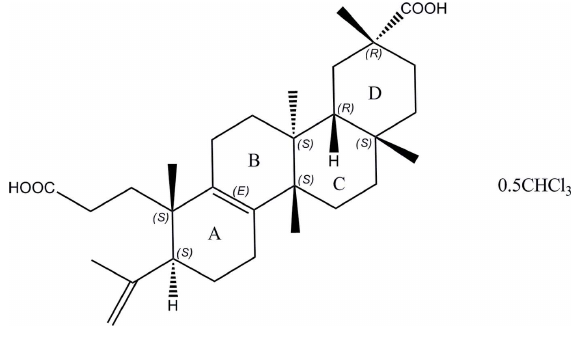
Data collection Bruker APEXII DUO CCD area- detector diffractometer Absorption correction: multi-scan ( SADABS ; Bruker, 2009)